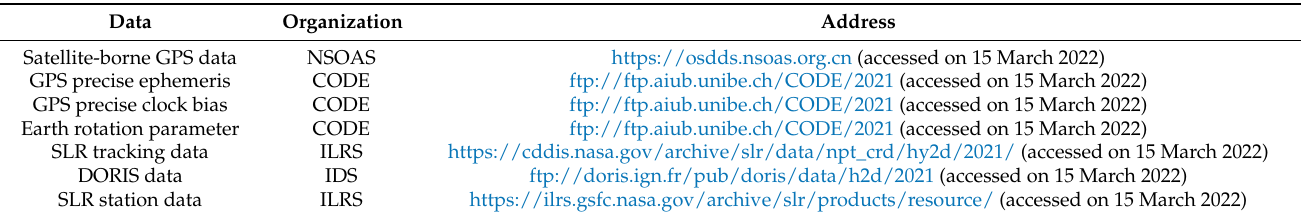
Table 2. Sources of data.